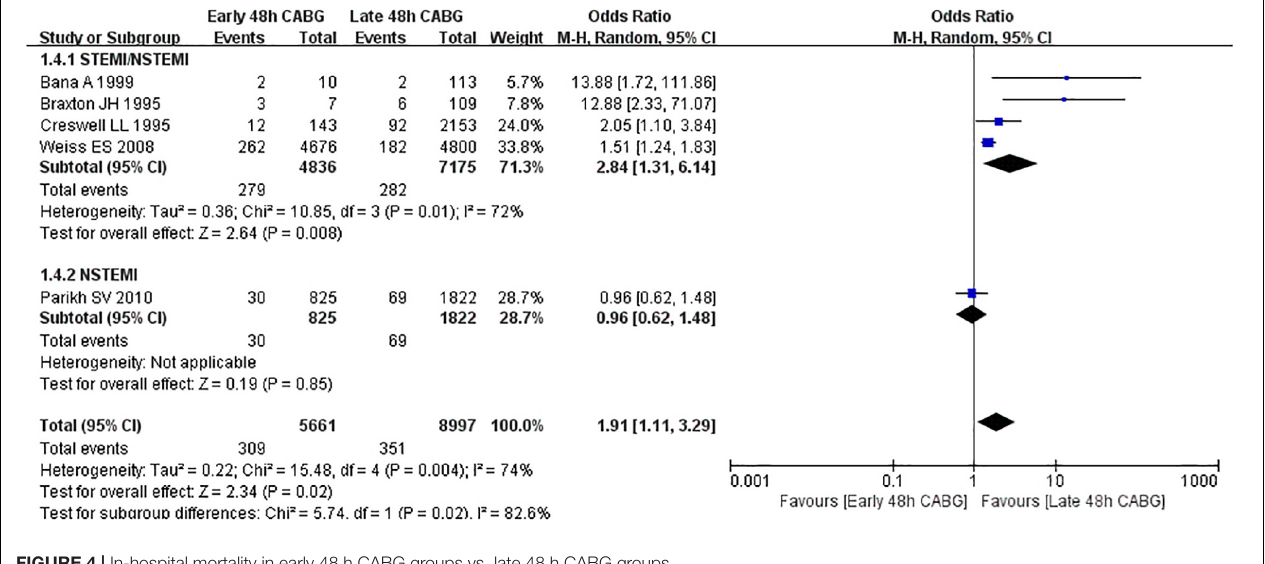
FIGURE 4 | In-hospital mortality in early 48 h CABG groups vs. late 48 h CABG groups.